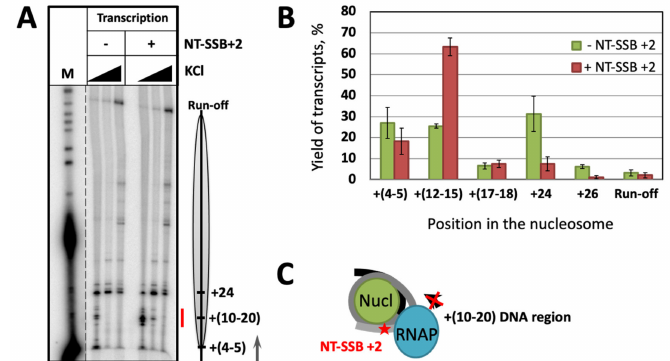
Figure 2. NT-SSB+2 induces arrest of RNAP during transcription of the +(10–20) region. ( A ) Transcrip- tion through 603 nucleosomes with and without single ssDNA break at the position +2 by E. coli RNAP for 2 min at 40, 150 or 300 mM KCl. Analysis of pulse-labeled RNA by denaturing PAGE. M—pBR322 MspI digest. Position of the nucleosome and direction of transcription are shown by the grey oval and arrow on the right, respectively. The +(10–20) region of RNAP arrest is shown by the red line. ( B ) Quantitative analysis of the RNA products obtained after transcription of the template with and without a nick at the position +2 at 40 mM KCl (averages of 3 experiments and standard deviations are shown). ( C ) The expected structure if the i-loop formed during transcription of the +(10–15) region. NT-SSB+2 is indicated by red